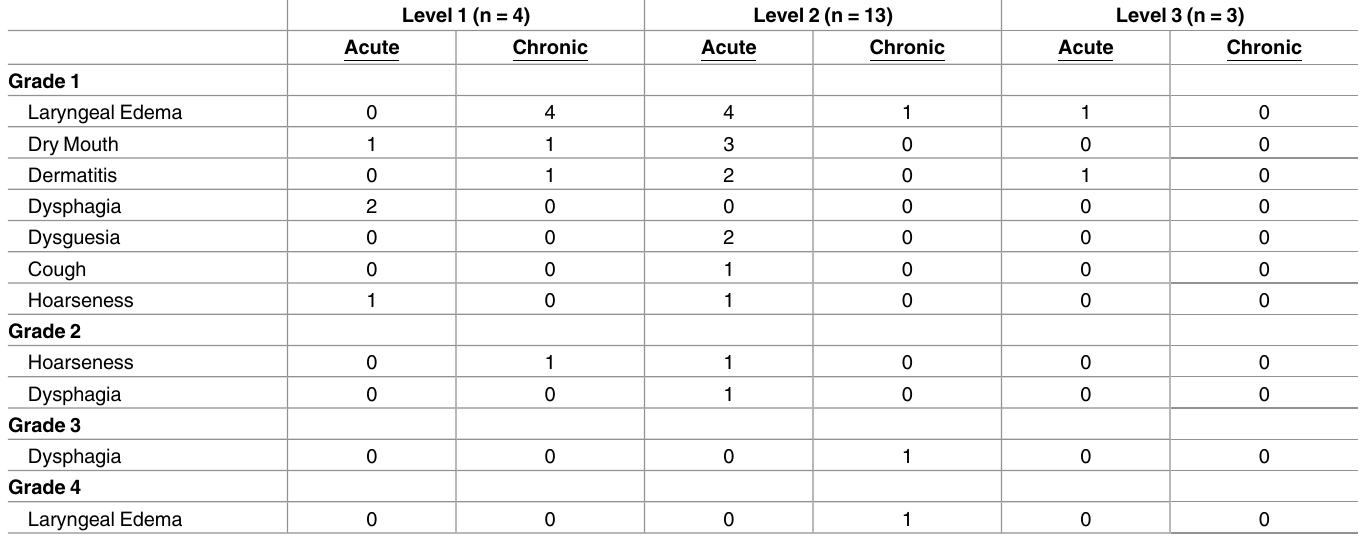
Table 2. Treatment